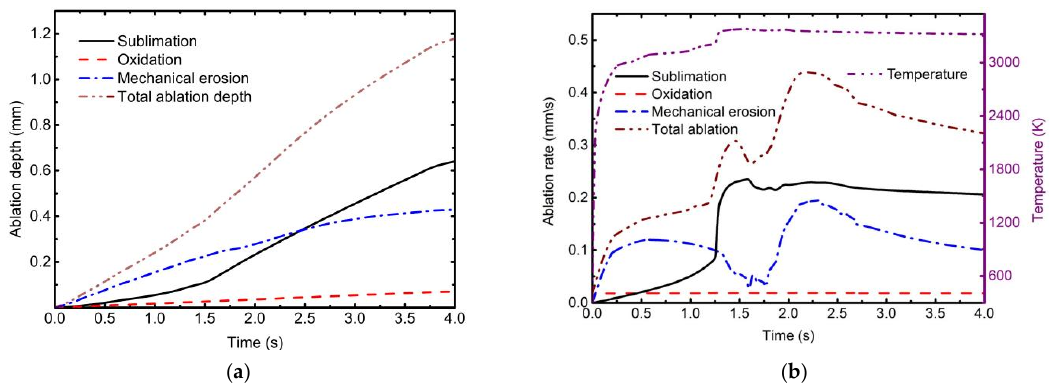
Figure 11. The effect of thermochemical ablation and thermomechanical erosion on laser ablation when laser power density is 2546 W/cm 2 and Mach number is 3.0. ( a ) Ablation depths; ( b ) ablation rates.